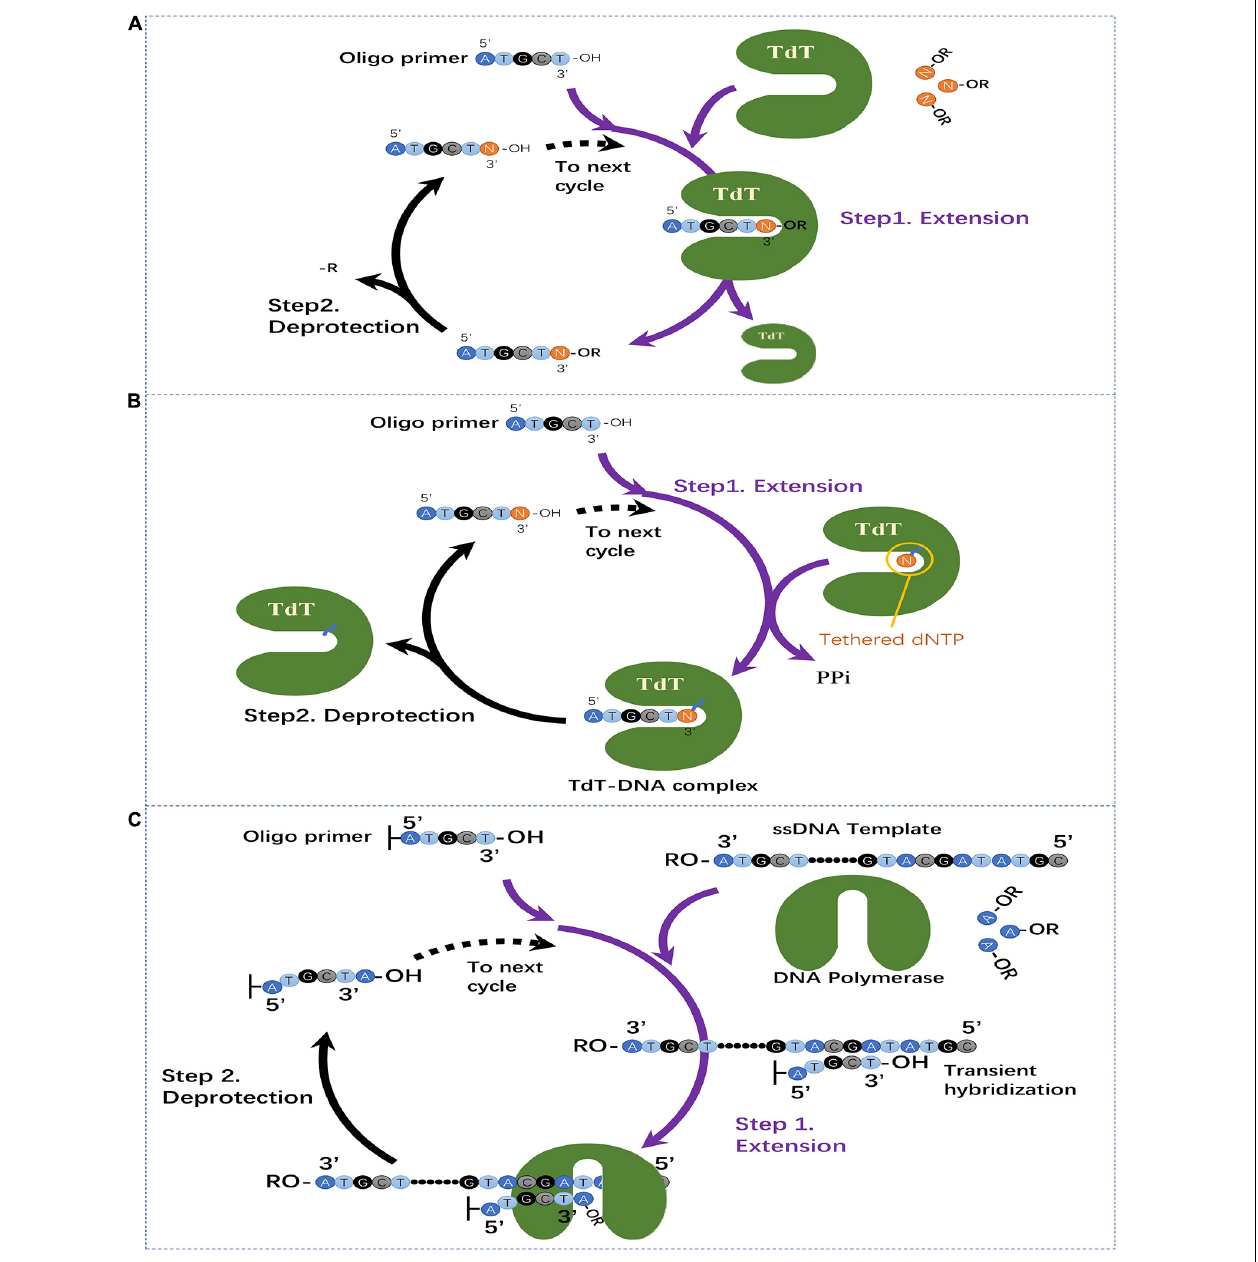
FIGURE 2 | Three recently emerged enzymatic oligo synthesis methods. (A) Two-step extension synthesis of DNA oligo using TdT and dNTPs with reversible blocking groups. (B) Two-step extension synthesis of DNA oligo using TdT–dNTP conjugates for reversible termination of oligo elongation. (C) Template-dependent polymerase mediated oligo synthesis by transient hybridization and chemically blocked substrates.